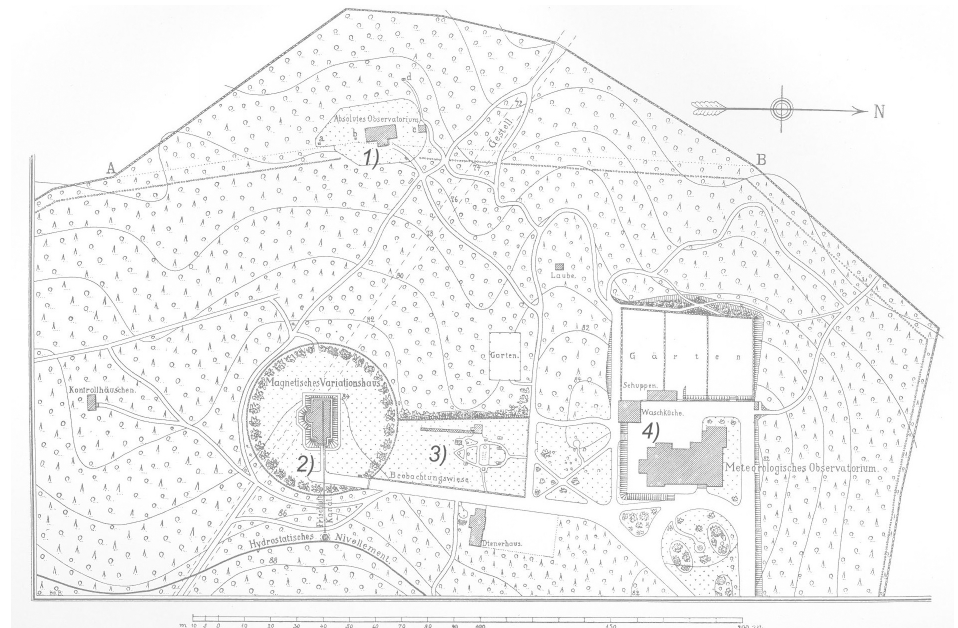
Figure 4. Final ground plan of the Potsdam Meteorological Magnetic Observatory. (1) Absolute house, (2) variation house, (3) meteorolog- ical observation field and (4) main building. Source: Brückmann (1911).